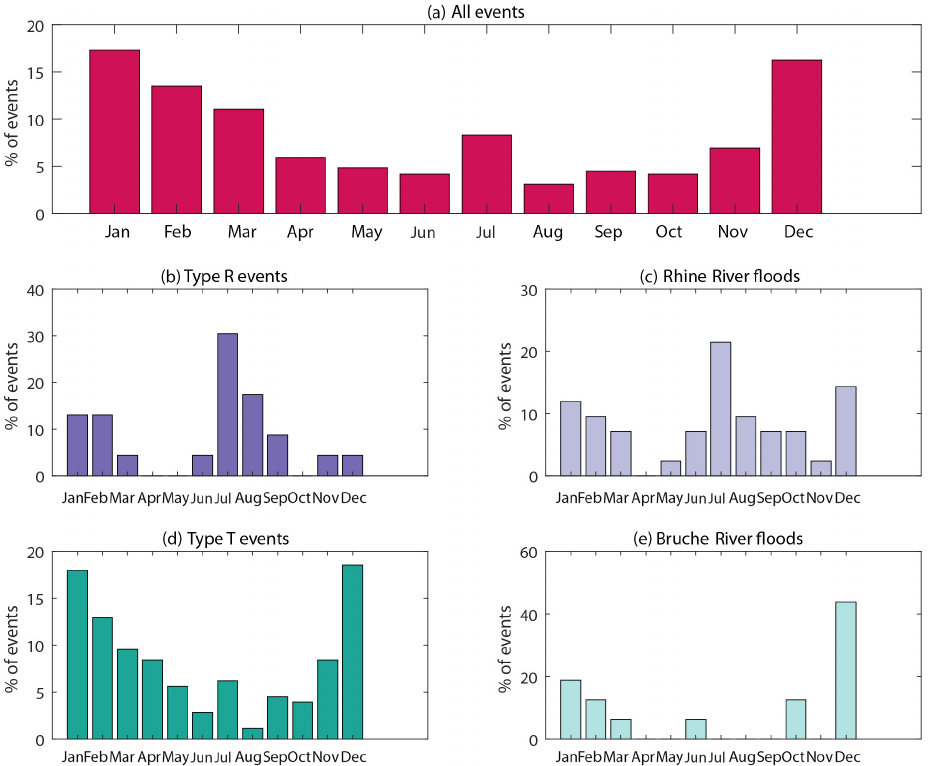
Figure 8. Flood event seasonality (monthly distribution) (a) for all events, (b–d) for the R (Rhine River alone) and T (Alsatian tributaries of the Rhine River alone) events, and (c–e) for all events with and without water overflow that have affected the Rhine and the Bruche rivers, respectively. For all events (a) , Type R events (b) , and Type T events (d) , water overflow has been reported in at least one river.